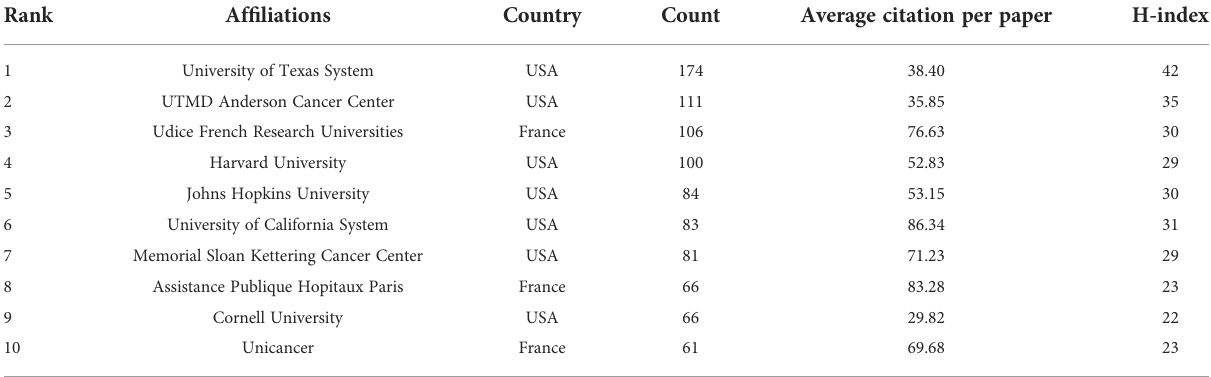
TABLE 2 The Top 10 af fi liations that contributed to the publications on BC immunotherapy research.